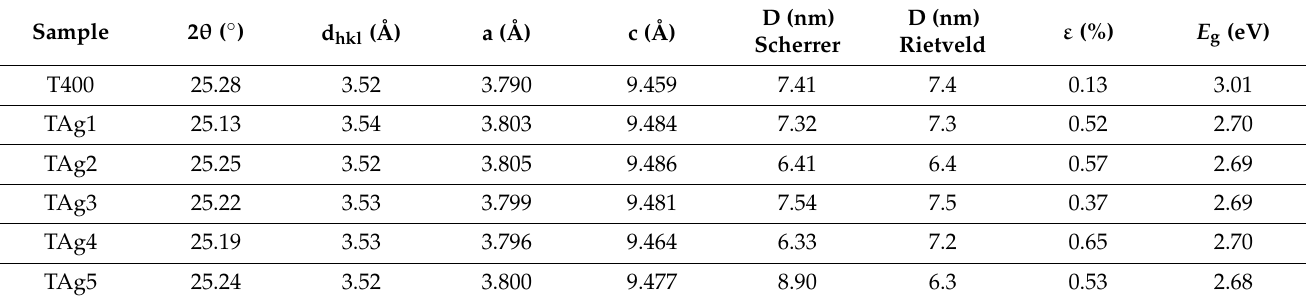
Table 1. Structural parameters of pure TiO 2 , and Ag–TiO 2 nanostructured nanofibers.